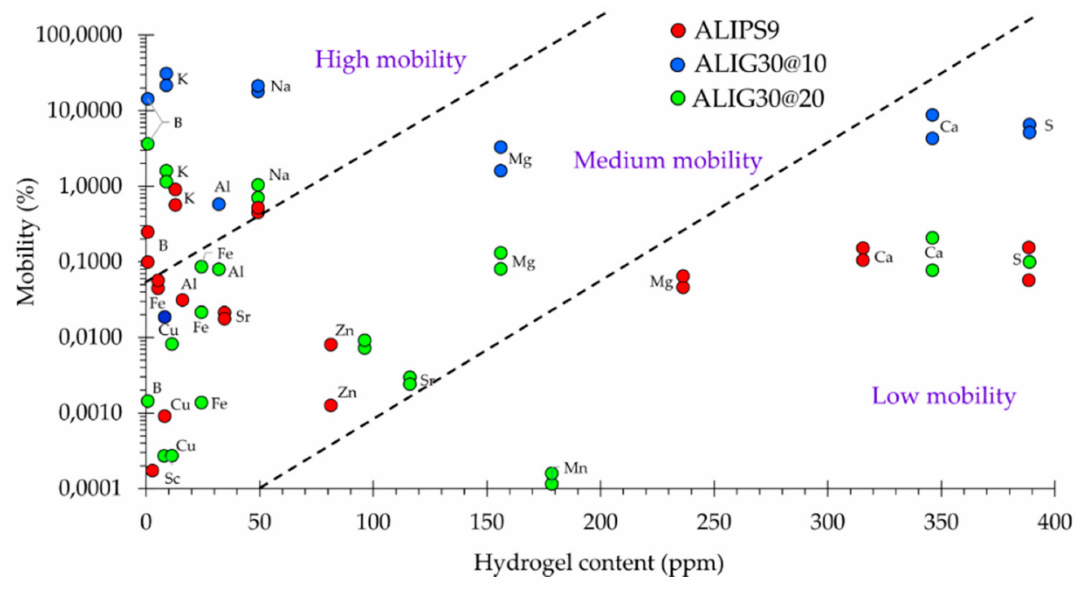
Figure 3. Percentage of mobility (logarithmic scale) versus total content of the element in ALIPS9, ALIG30@10 and ALIG30@20 hydrogels (ppm). “High”, “Medium” and “Low mobility” areas are hypothetical. Non-detected elements (mobility = 0%) do not appear in the logarithmic